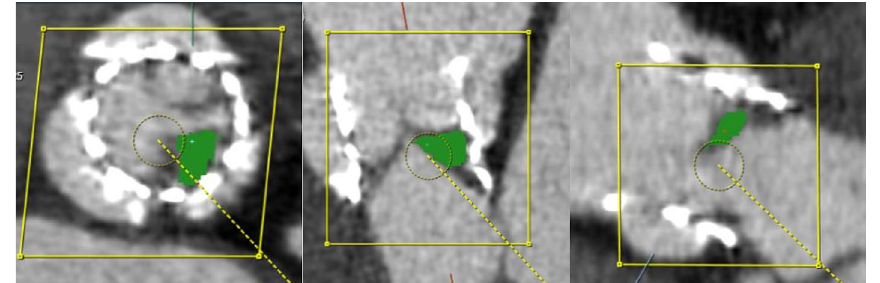
Figure 5. Cardiac CT images of an 83-year-old female exhibiting leaflet thrombosis of the bioprosthetic aortic valve. An ROI is drawn along the hypoattenuated leaflet thickening of the bioprosthetic aortic valve (green color). CT, computed